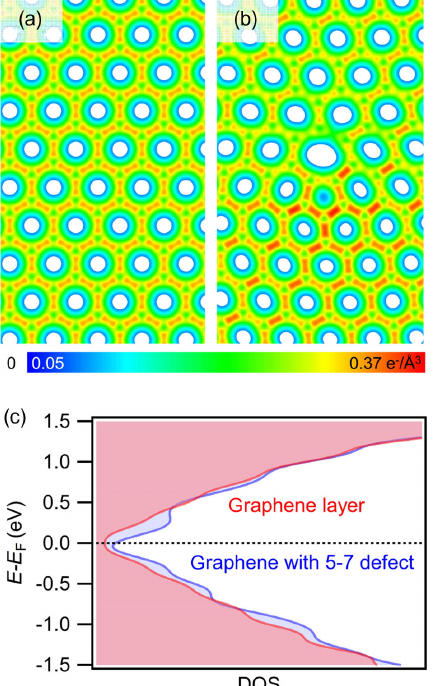
FIG. 12. Results of periodic DFT calculations for a freestanding graphene layer with and without 5-7 defects. (a) The section through the charge density for the planar ideal graphene layer and (b) the section through the charge density for the planar graphene layer with a 5-7 defect. As can be seen, the 5-7 defect accumulates negative charge (red) at the 5-membered ring and positive charge (blue/white) at the 7-membered ring. Only part of the unit cell is shown. For a complete view, see Fig. S9 of the Supplemental Material [44]. (c) Total density of states for both systems. The DOS of the defect structure shows new states around the Fermi energy. The nonzero DOS at E for both F systems is caused by the employed electronic smearing and is a known artifact of the method